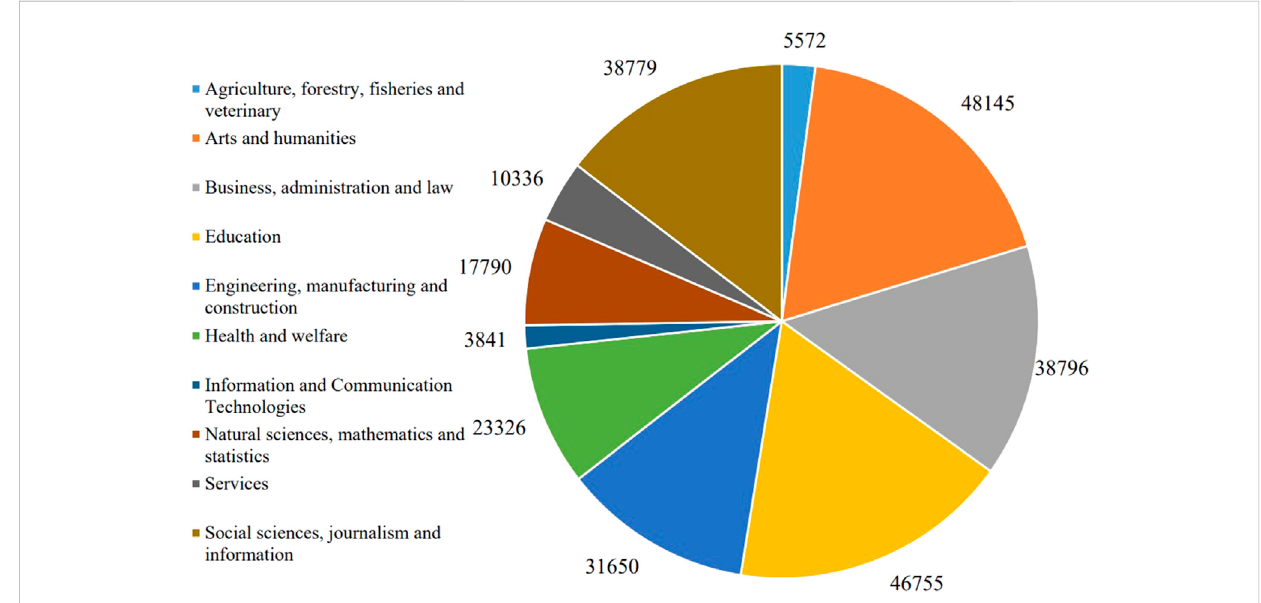
FIGURE 5 Distribution of bachelor ’ s graduates by educational fi eld, Italy, 2020. Source: own processing according to data published by Eurostat,